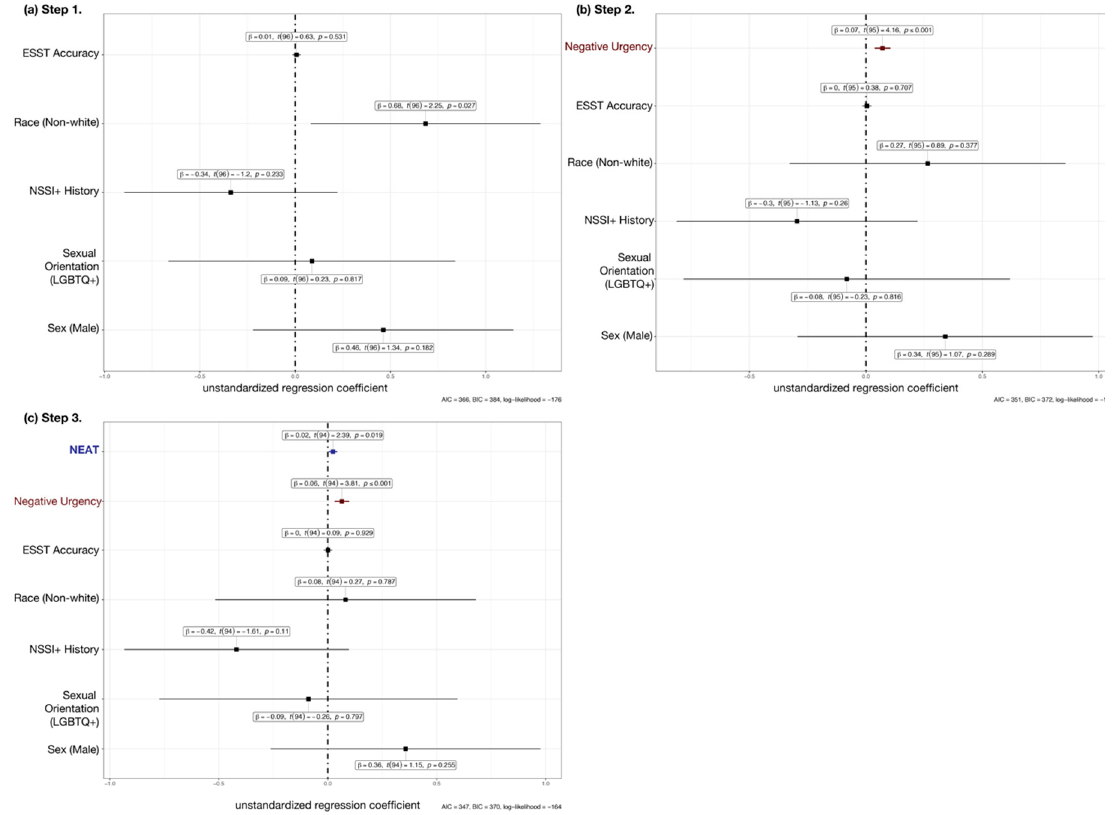
Figure 1. Multiple linear regression results for EDE-Q global scale scores with predictors entered hierarchically in three steps: ( a ) Sex, gender / sexual orientation, race, NSSI history, ESST accuracy